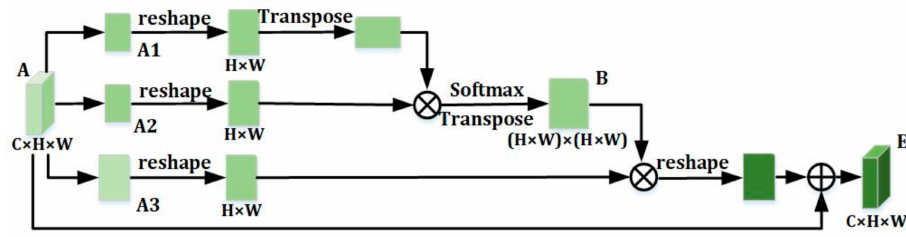
Figure 3. The position attention module